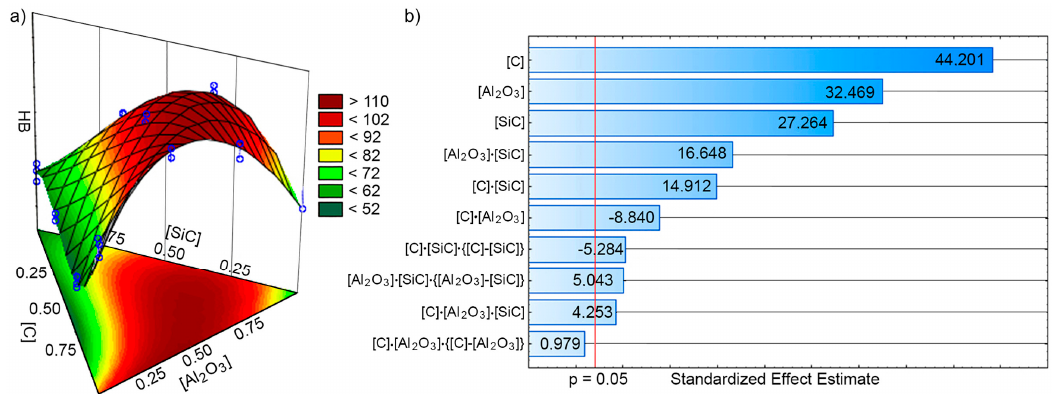
Figure 4. The effect of particulates content on the MMC hardness: ( a ) 3D HB function and isoplates; ( b ) Pareto chart.